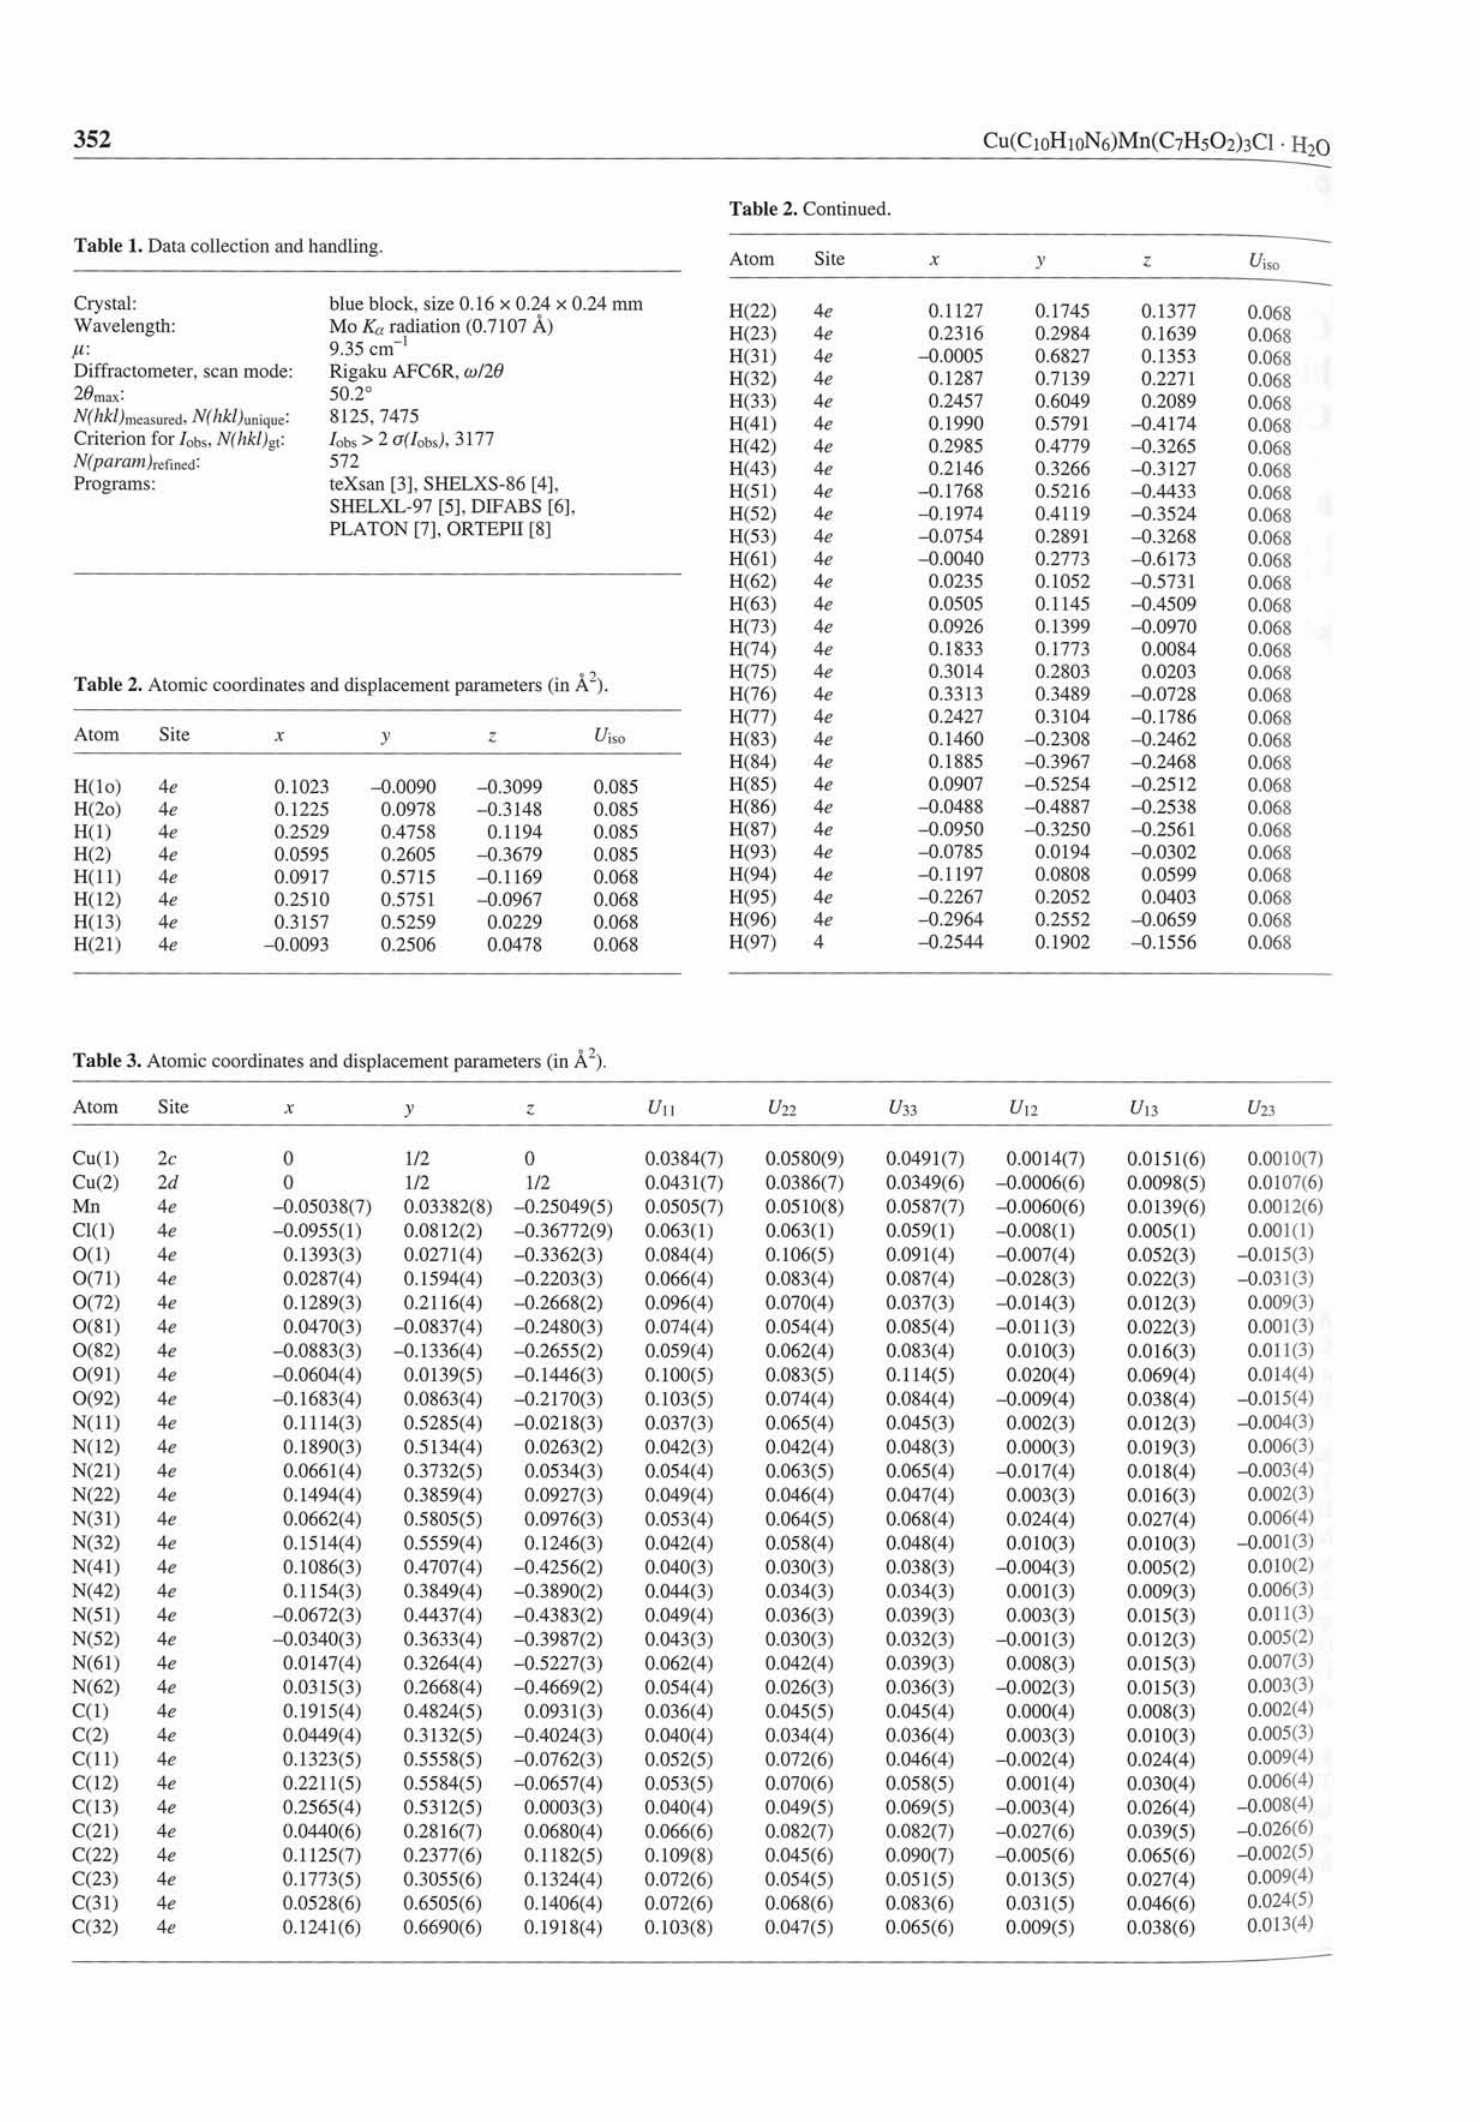
Table 2. Atomic coordinates and displacement parameters (in Â").